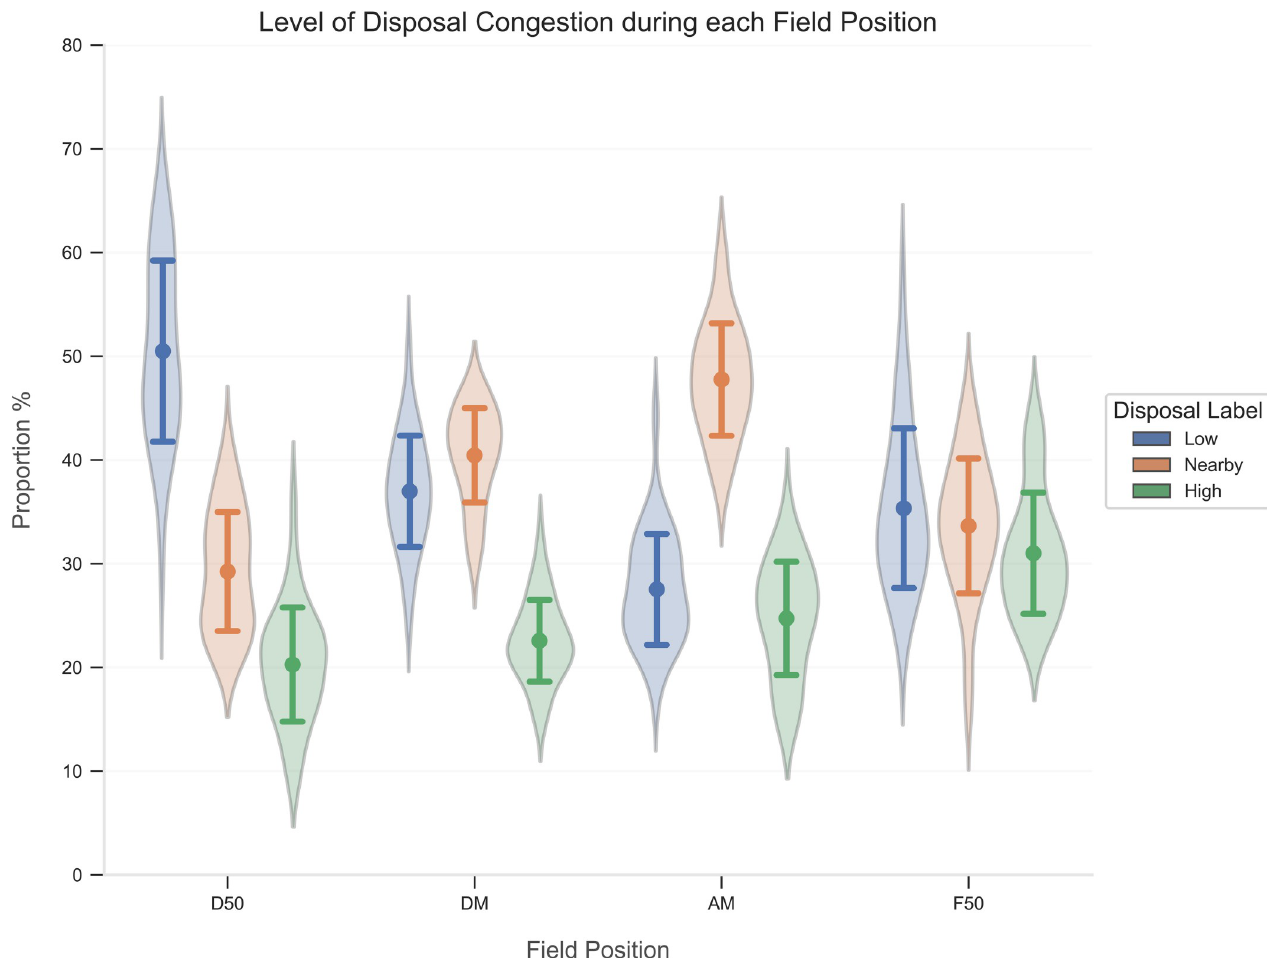
Fig 7. Breakdown of disposals (mean ± standard deviation) in each level of congestion compared across field position. D50, Defensive 50; DM, Defensive Midfield; AM, Attacking Midfield; F50, Forward